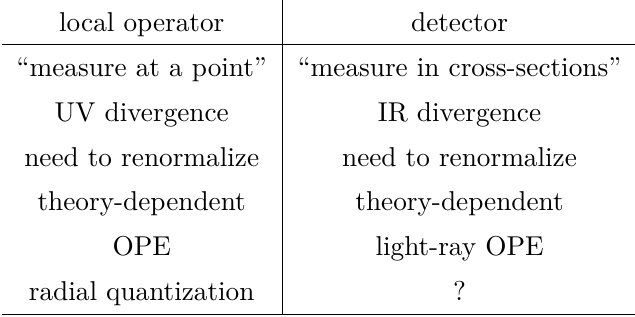
Table 1. A comparison between local operators and